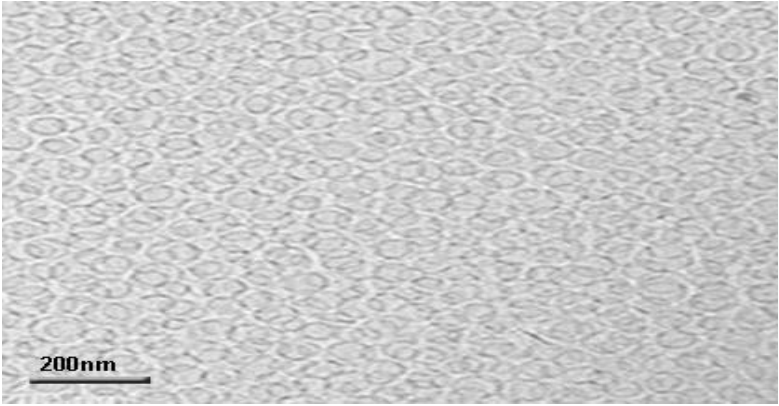
Figure 7. TEM-magnified vesicular image of optimized transferosome-loaded proanthocyanidin.